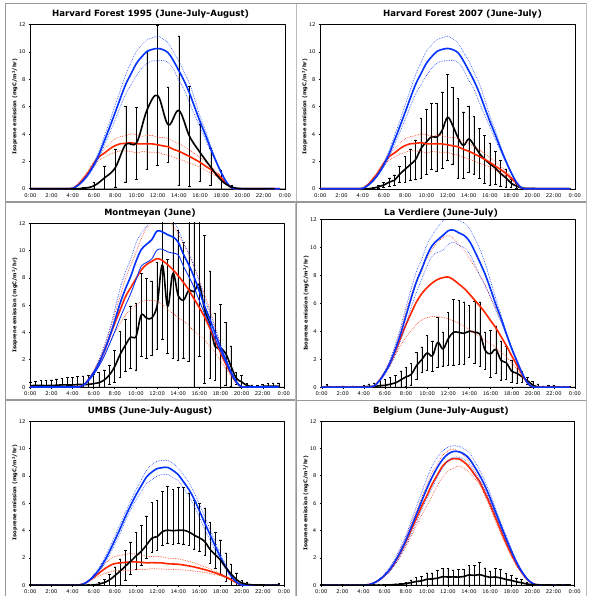
Fig. 9b. (a–c) Comparison between measured and modeled isoprene emission and GPP average diurnal cycles for the time periods in- dicated in Table 6. Measurements are black lines. Error bars on the measurements represent ± 1 standard deviation. Model results are 10yr climatological averages for SimCONT (red) and SimH2O (blue). The dotted lines represent model uncertainty due to internal variability in the climate model computed as ± 1 standard deviation for n =10 model run years. (b) isoprene mission temperate sites.